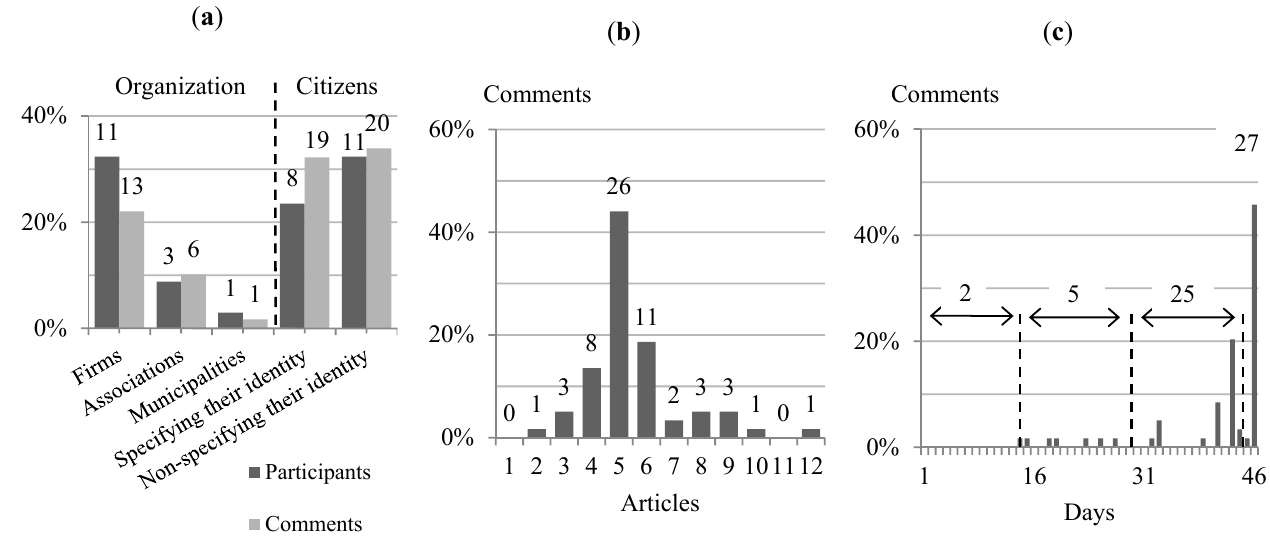
Figure 5. Elaboration of e-consultation comments. ( a ) Type of participants; ( b ) Comments by article; ( c ) Submission